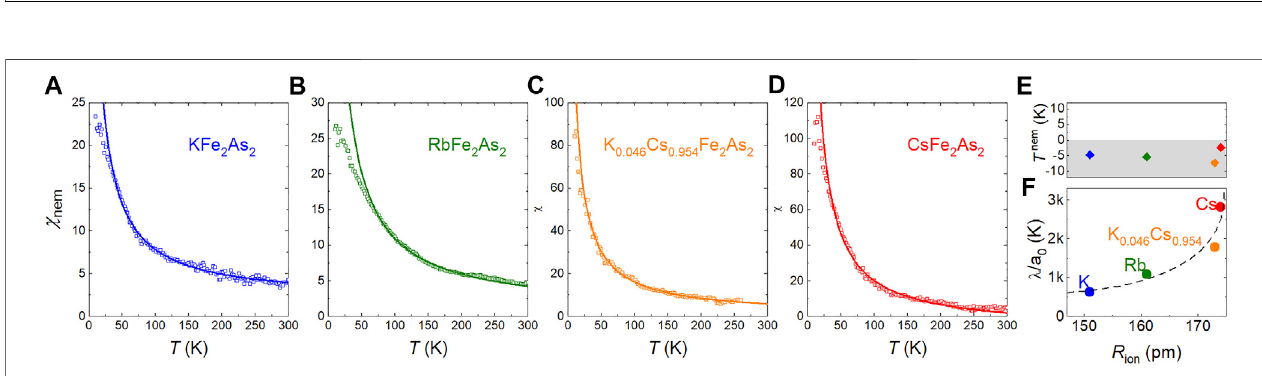
FIGURE 2 | Temperature dependence of elastoresistance χ er of the data (see text). The fi t parameters T nem and λ / a 0 are summarized in (E,F) , respectively. The dotted line in (F) is a guide to the eye.